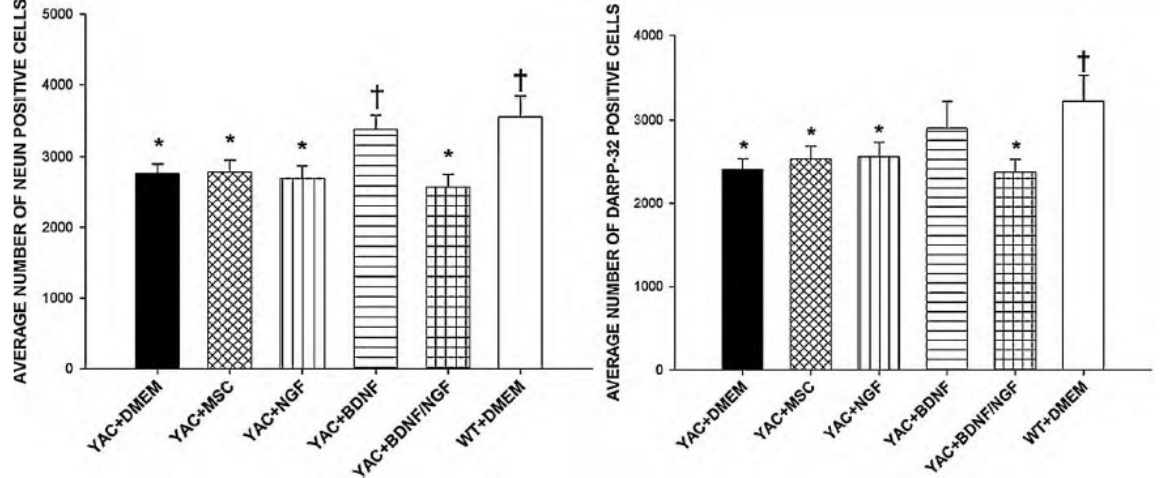
displayed a normalization of total neurons within the striatum, and protected against significant losses of DARPP32 neurons (Figure 2). Figure 2. Neuroprotective effects of NTF secreting MSCs. Sparing of NeuN-positive (left) and Darpp-32-positive (right) cells was observed in YAC 128 mice that received striatal transplants of mesenchymal stem cells (MSCs) that were genetically altered to over-express brain derived neurotrophic factor (YAC + BDNF), but not in mice that received transplants of MSCs that were genetically modified to over-express nerve growth factor (YAC + NGF), a combination of MSCs that over-expressed both NGF and BDNF (YAC + BDNF/NGF), or unaltered MSCs (YAC + MSC). Note: * indicates a significant